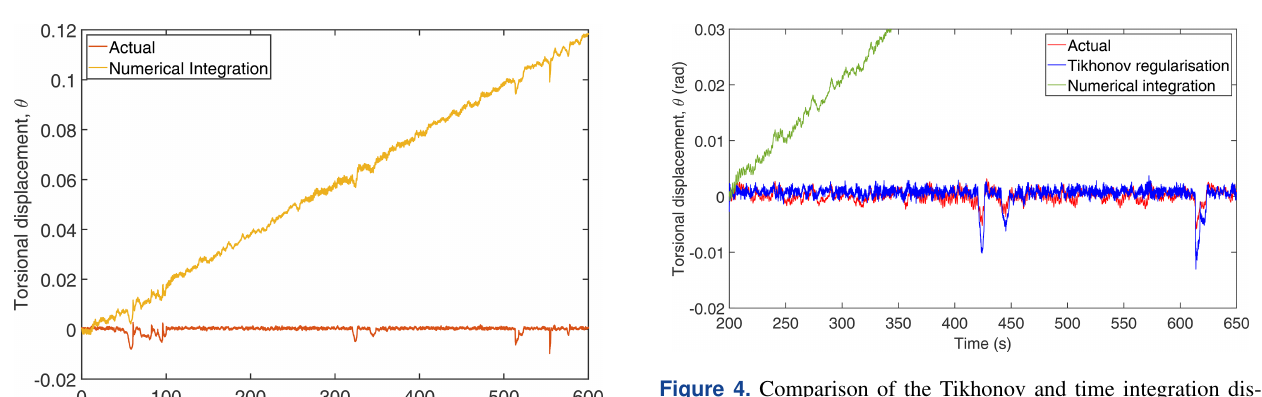
Figure 4. Comparison of the Tikhonov and time integration dis- placements with actual